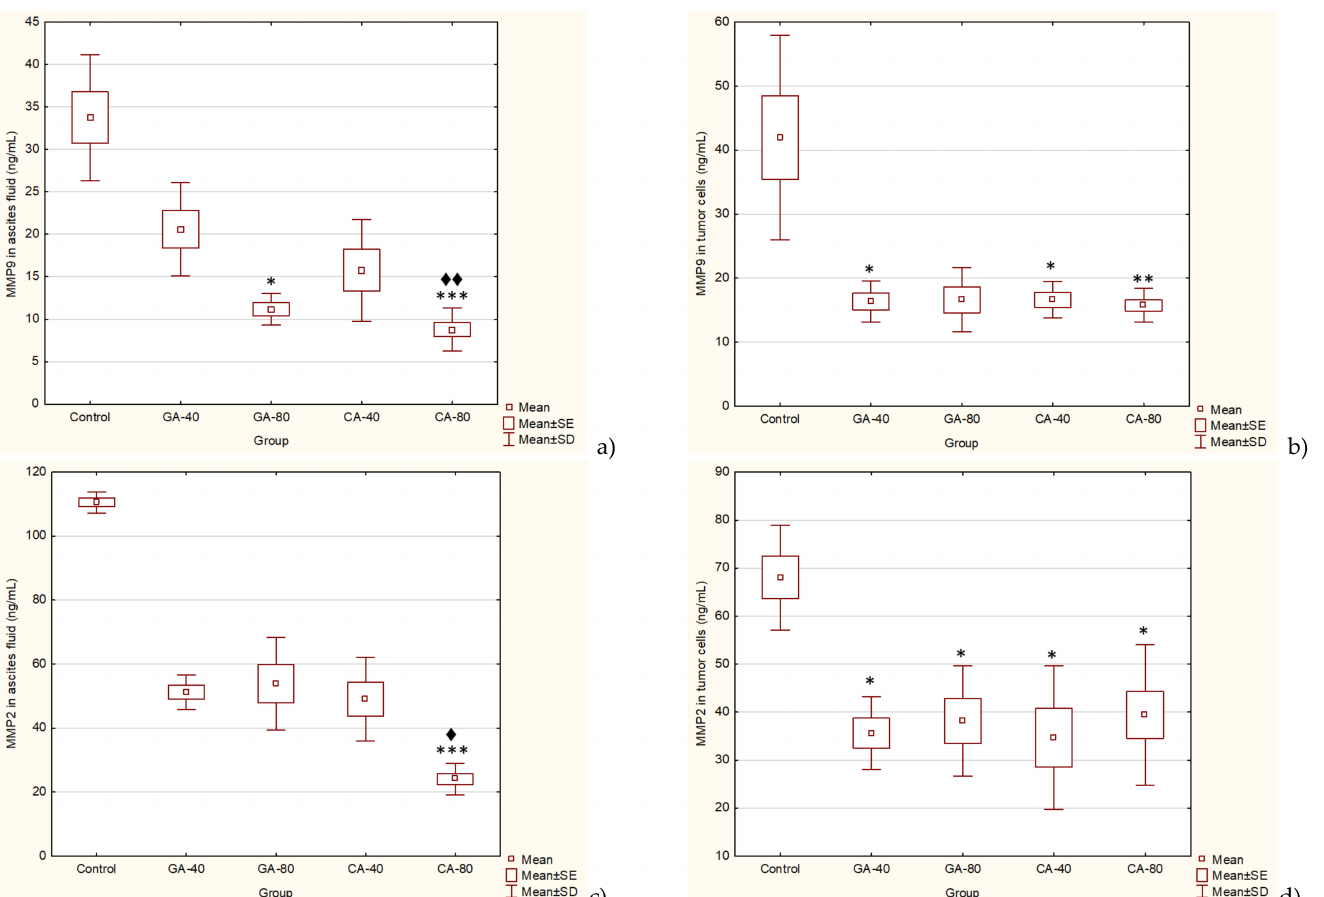
Figure 5. E ff ect of GA and CA on the MMP-9 ( a , b ) and MMP-2 ( c , d ) levels in ascites fluid and tumor cells of mice bearing EAT. Mice were injected intraperitoneally ( ip ) with 2.5 × 10 6 viable EAT cells and treated with GA or CA at a dose of 40 and 80 mg / kg ip in exponential tumor growth phase on days 5, 7, 9, and 11. Mice were sacrificed on the 13th day, ascitic fluid and tumor cells were collected, and the MMP-9 or MMP-2 levels were estimated by ELISA. The results are expressed as the mean value of each experimental group ± SE of the mean of three di ff erent observations; * p < 0.05, ** p < 0.01, *** p < 0.001 as compared to the control group treated with saline; (cid:7) p < 0.05, (cid:7)(cid:7) p < 0.01 as compared to GA-40. Abbreviations: EAT, Ehrlich ascites tumor; GA, gallic acid; CA, ca ff eic